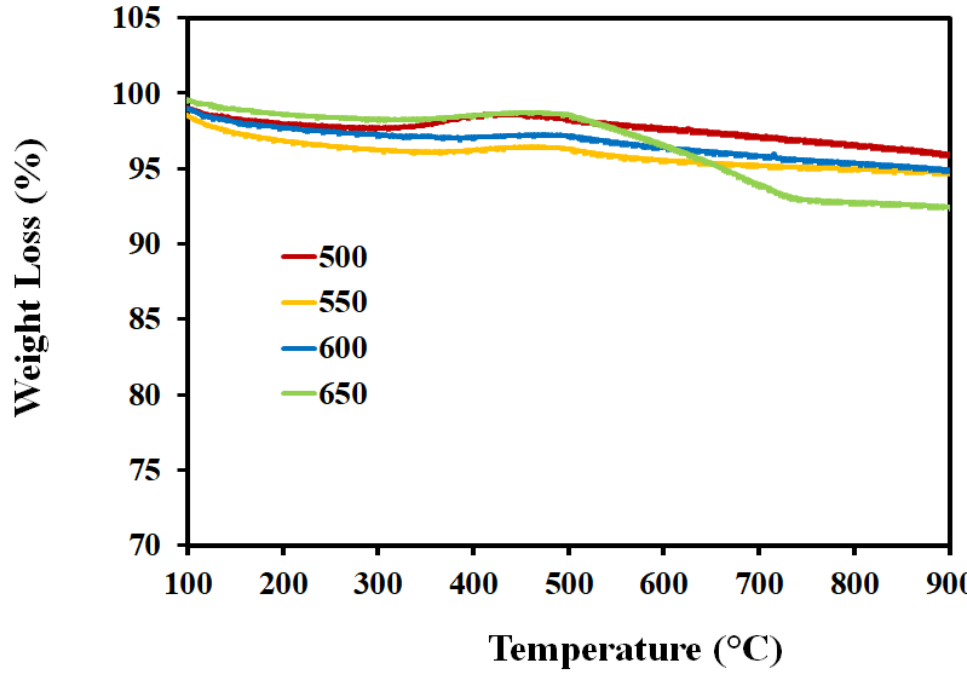
Figure 14. TGA analysis of the Ni-Al-H-600 catalyst obtained at different reaction temperatures for 7 h.